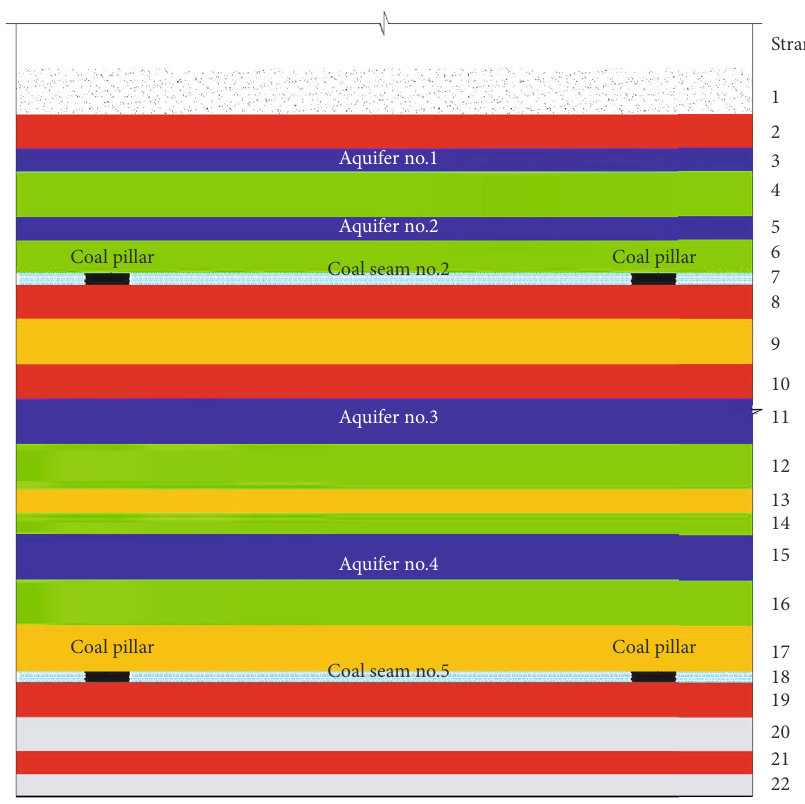
Figure 14: Physical model (partial) pro fi